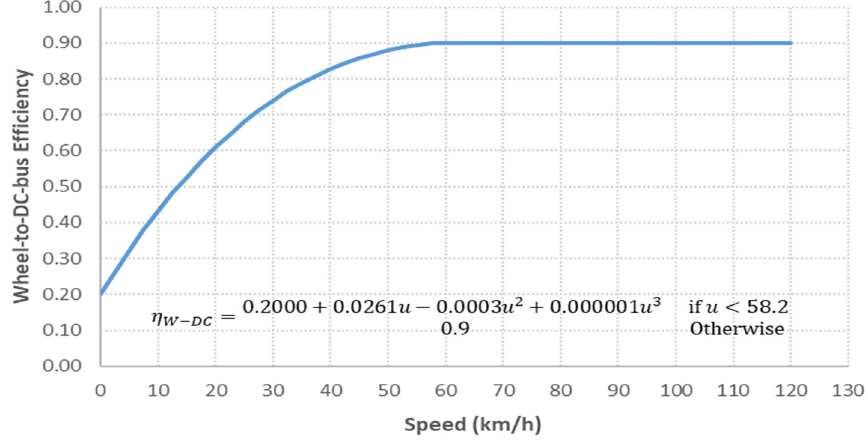
Figure 3. Wheel-to-DC-bus efficiency. Figure 3. Wheel ‐ to ‐ DC ‐ bus efficiency.